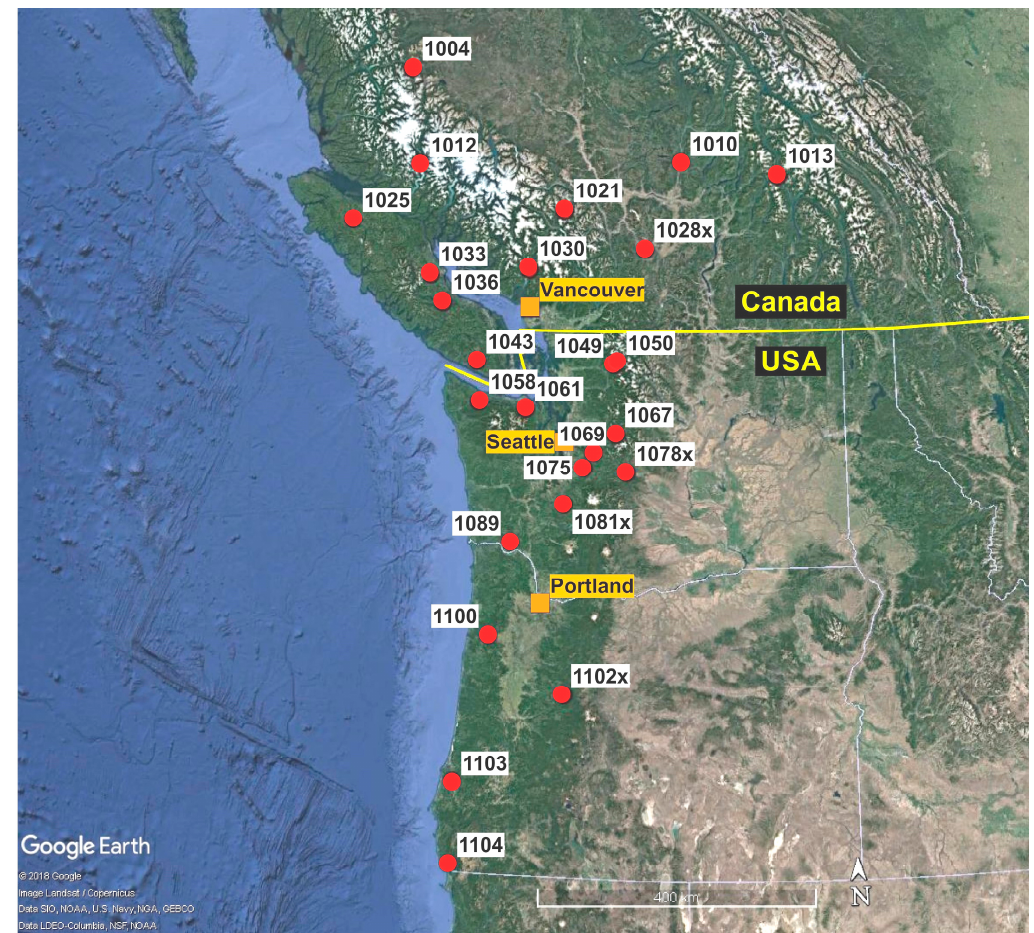
Figure 1. Map of provenances examined at the H ů rky trial in their natural range of occurrence in western North America; source: Google Earth Pro. Table 1. Characteristics of evaluated provenances at the H ů rky area.